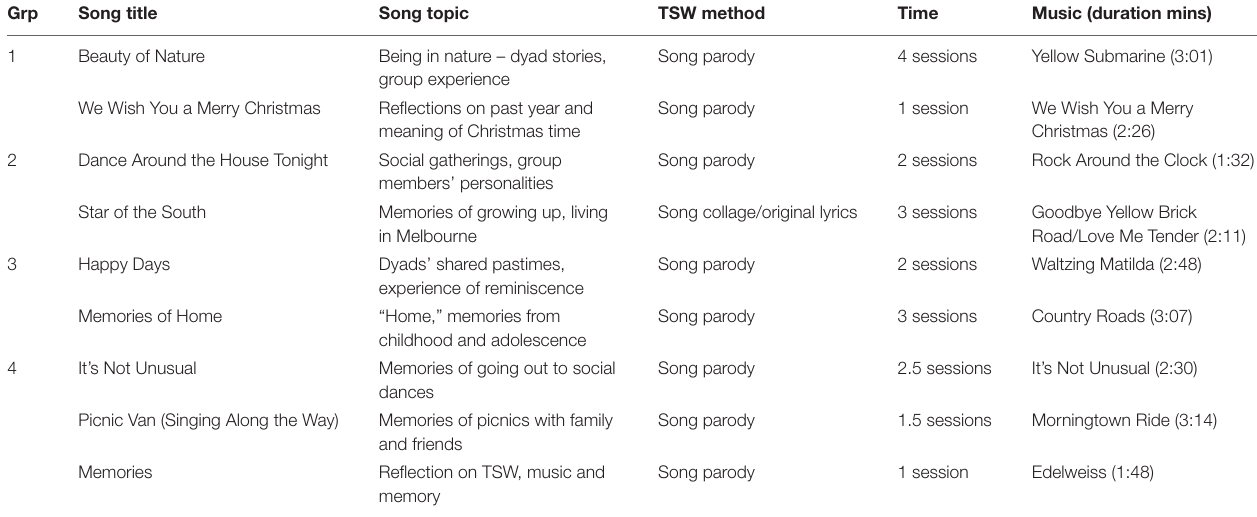
TABLE 2 | Description of group song